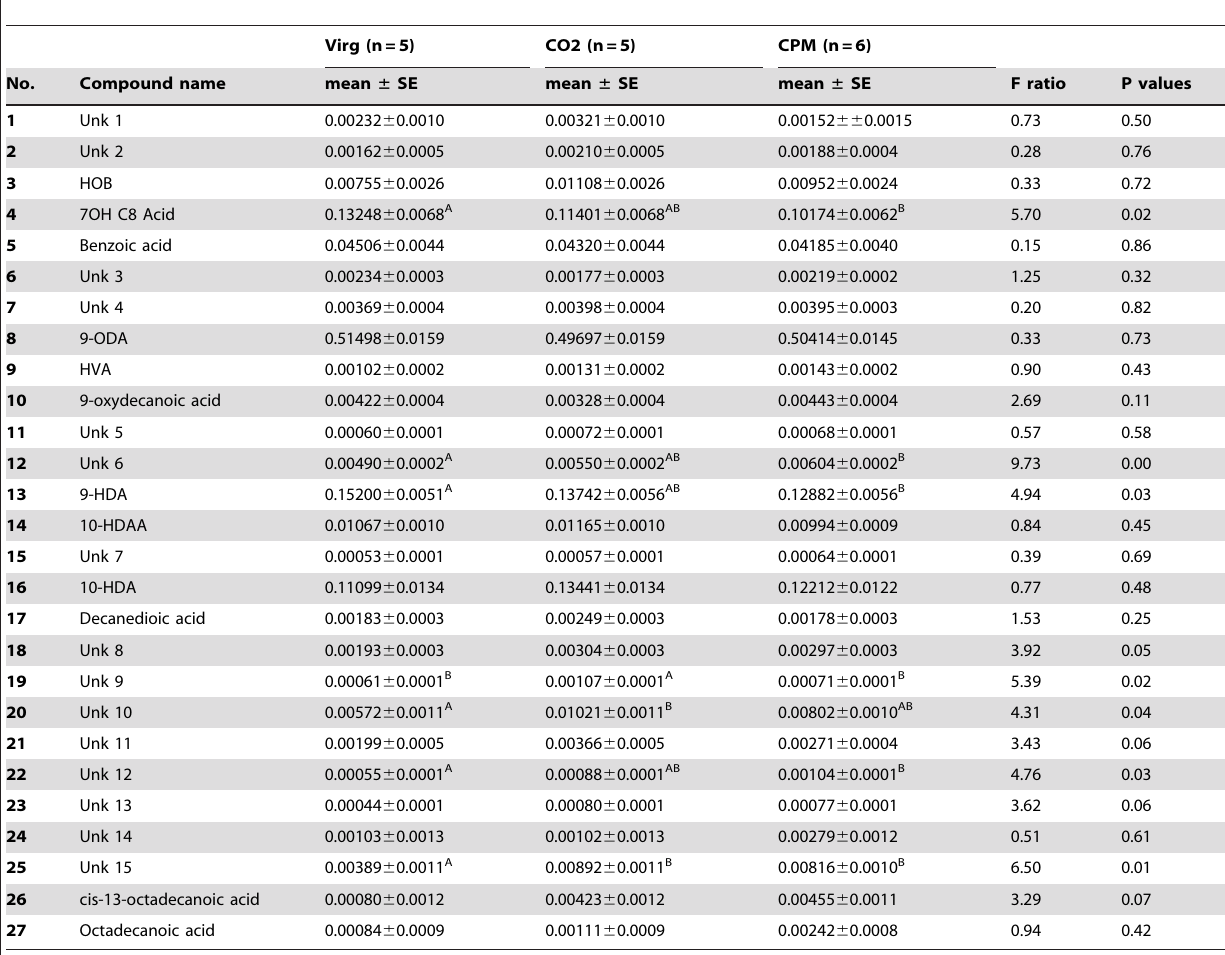
Table 1. Relative proportions of compounds found in mandibular glands of Virg, CO 2 , and CPM